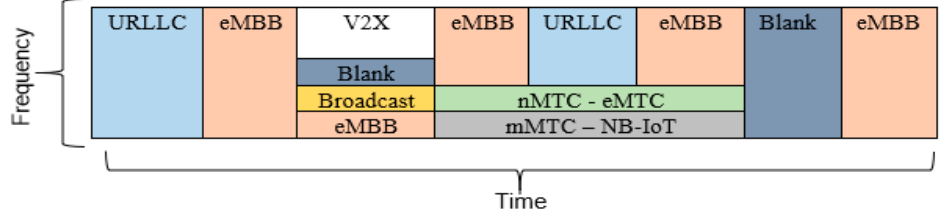
Figure 2. The flexible frame structure of 5G new radio (NR) [2]. URLLC, ultra ‐ reliable low latency